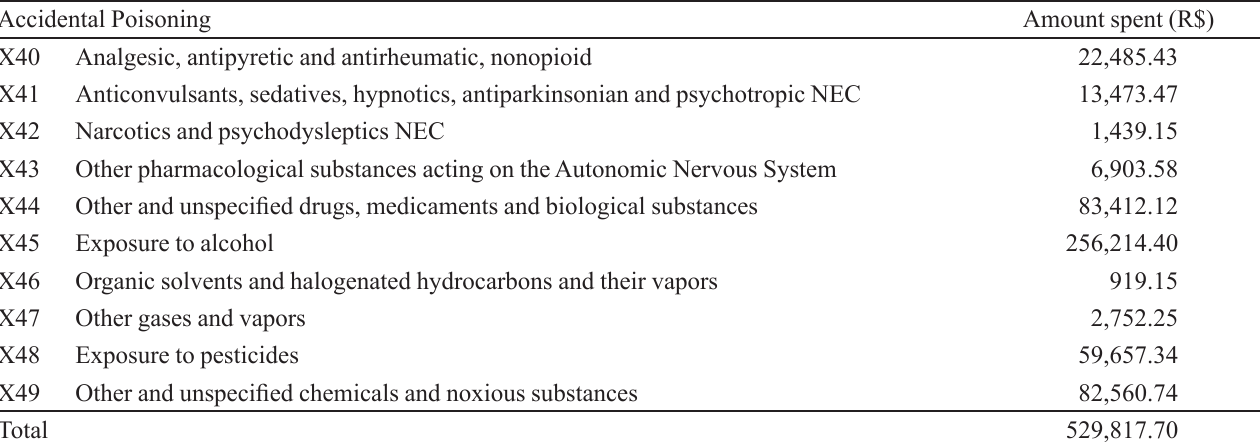
TABLE IV – Expenditure on hospitalizations for accidental poisoning in the elderly. Brazil, 2008-2009